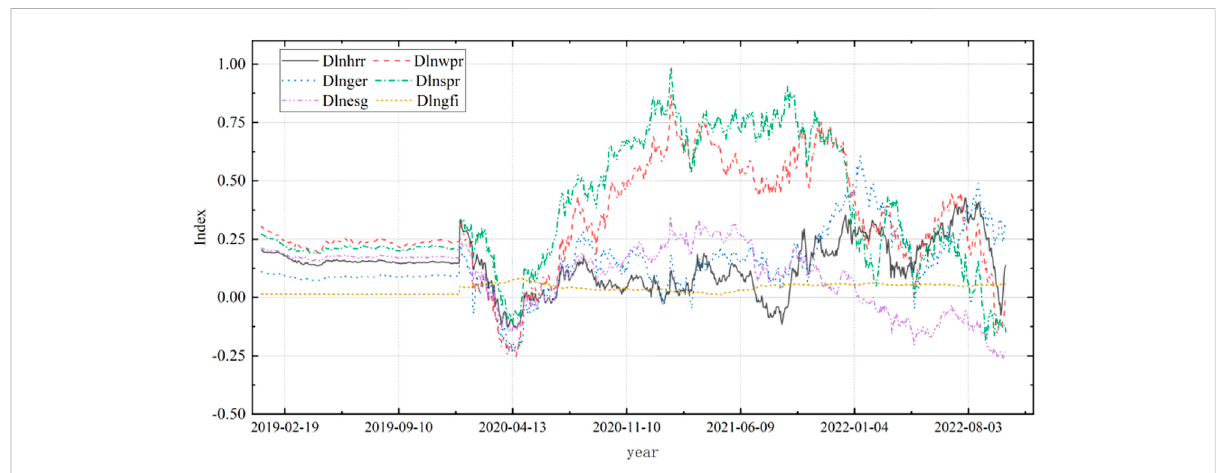
FIGURE 2 Time series of renewable energy.